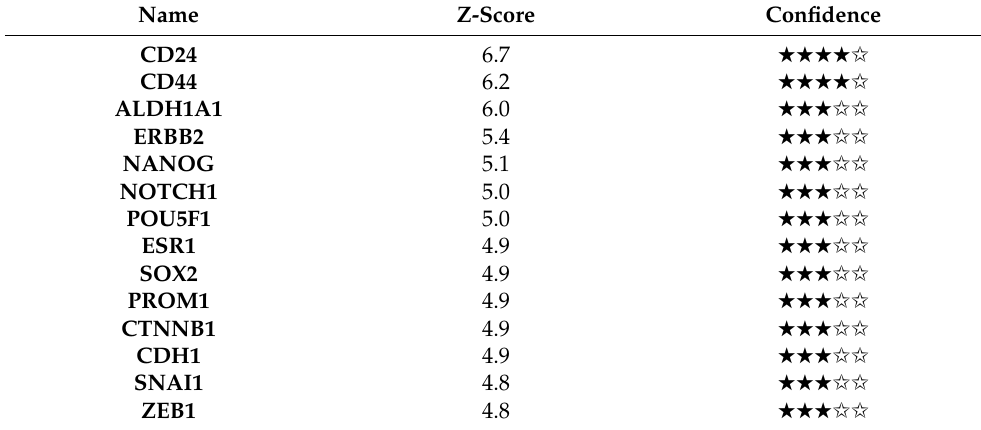
Table 3. Stem cell genes with highest